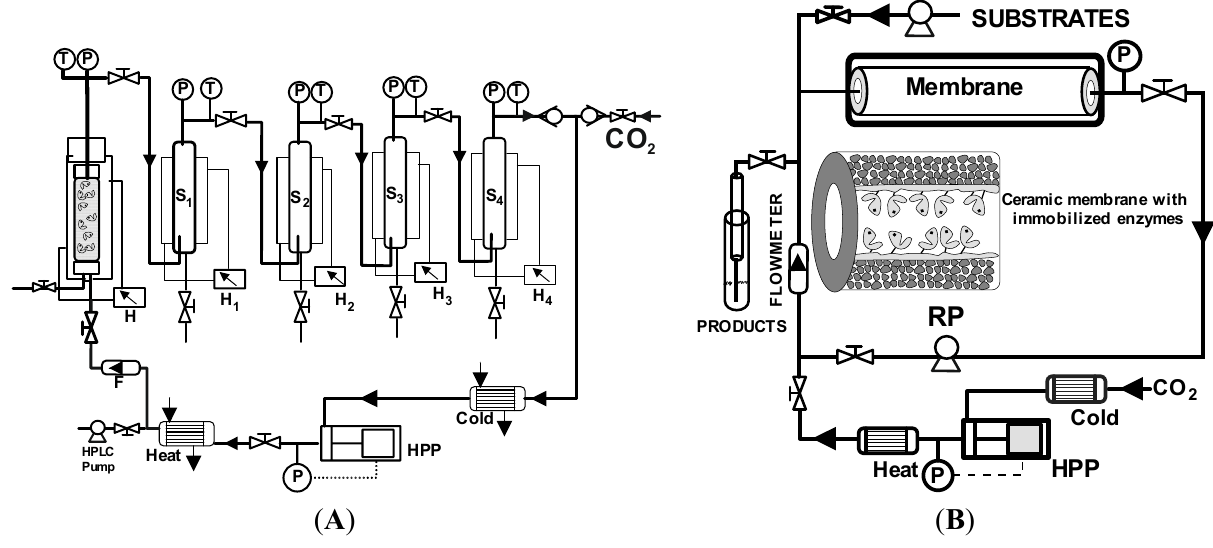
Figure 2. ( A ) High-pressure packed bed enzyme-reactor with recirculation, equipped with high pressure pump (HPP), separators (S), heaters (H), pressure (P) and temperature control (T), and flowmeter (F) for Lipozyme ® -catalyzed ethyl oleate synthesis in [26]; ( B ) High-pressure enzymatic membrane reactor with recirculation (B) for scCO 2 biotransformations in scCO 2